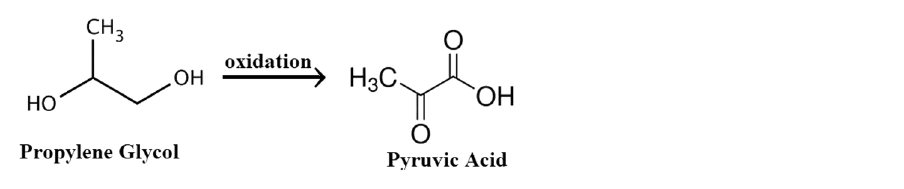
Scheme 1. Propylene glycol